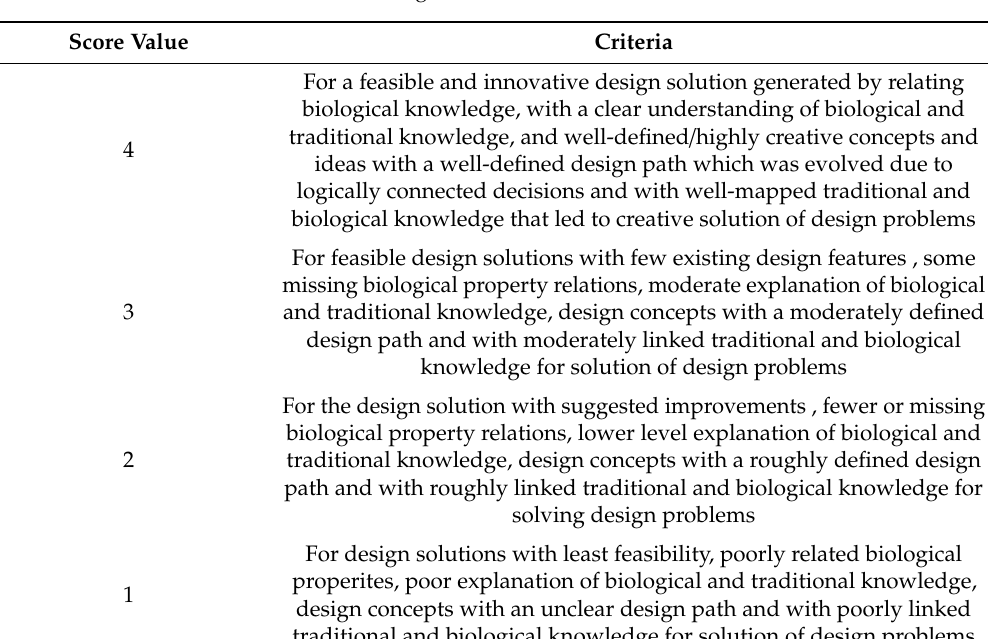
Table 2. Criteria for Assignment of Score Value to Each